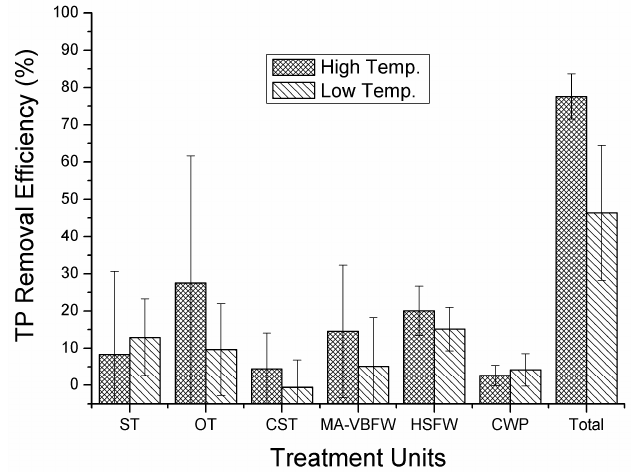
Figure 4. Total phosphorus (TP) removal efficiency in different treatment stages during summer and winter.